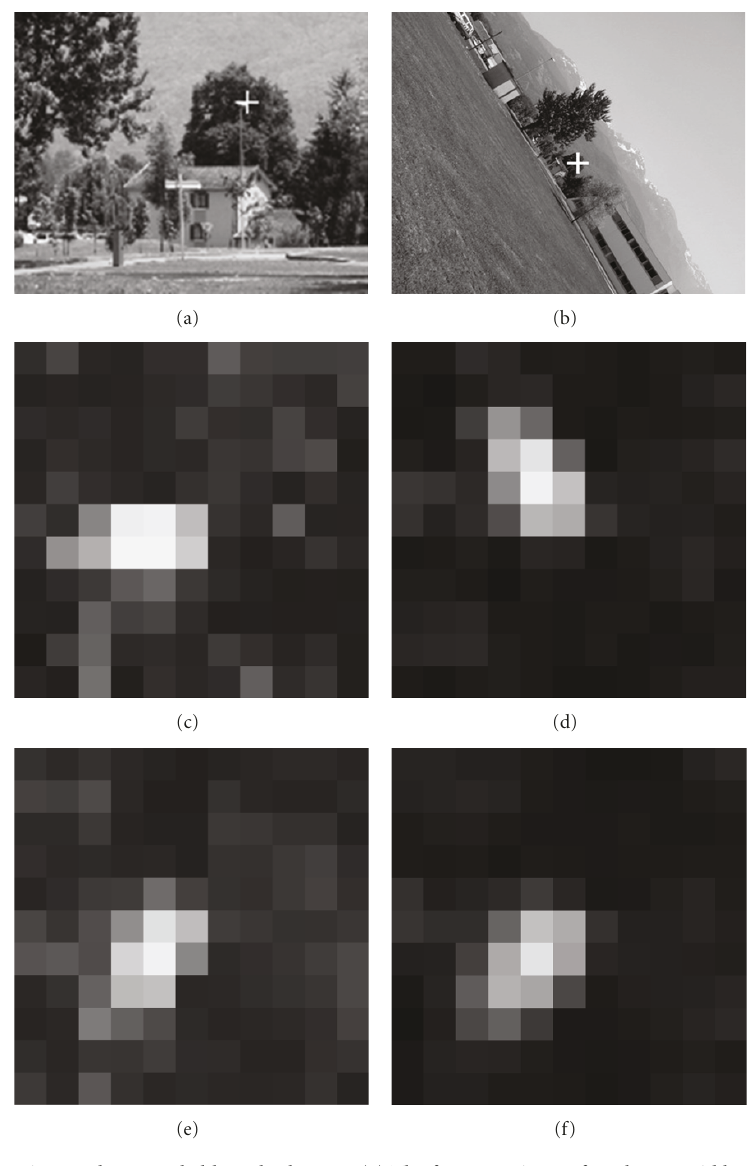
Figure 3: Matching feature points under remarkable scale changes. (a) The feature point on fourth pyramid level for the first image. (b) The feature point on first pyramid level for the second image. (c) and (d) 11 × 11 correlation window of the two feature points before orientation normalization. (e) and (f) 11 × 11 correlation window of the two feature points after orientation normalization.